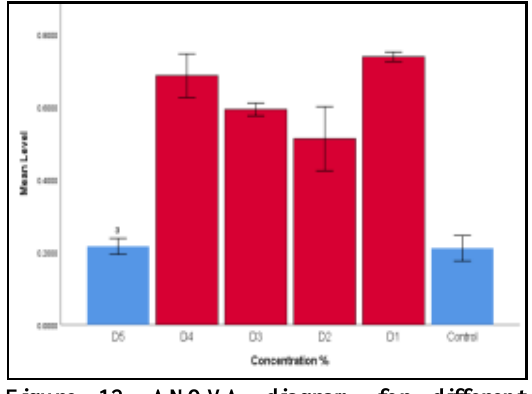
Figure 12. ANOVA diagram for different concentrations of fraction